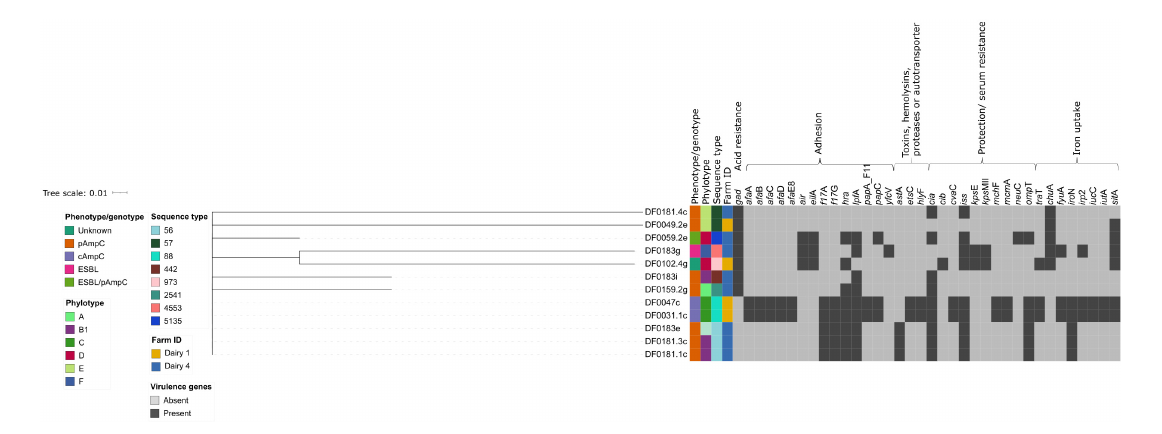
E. coli (EPEC), respectively (Robins-Browne et al.,